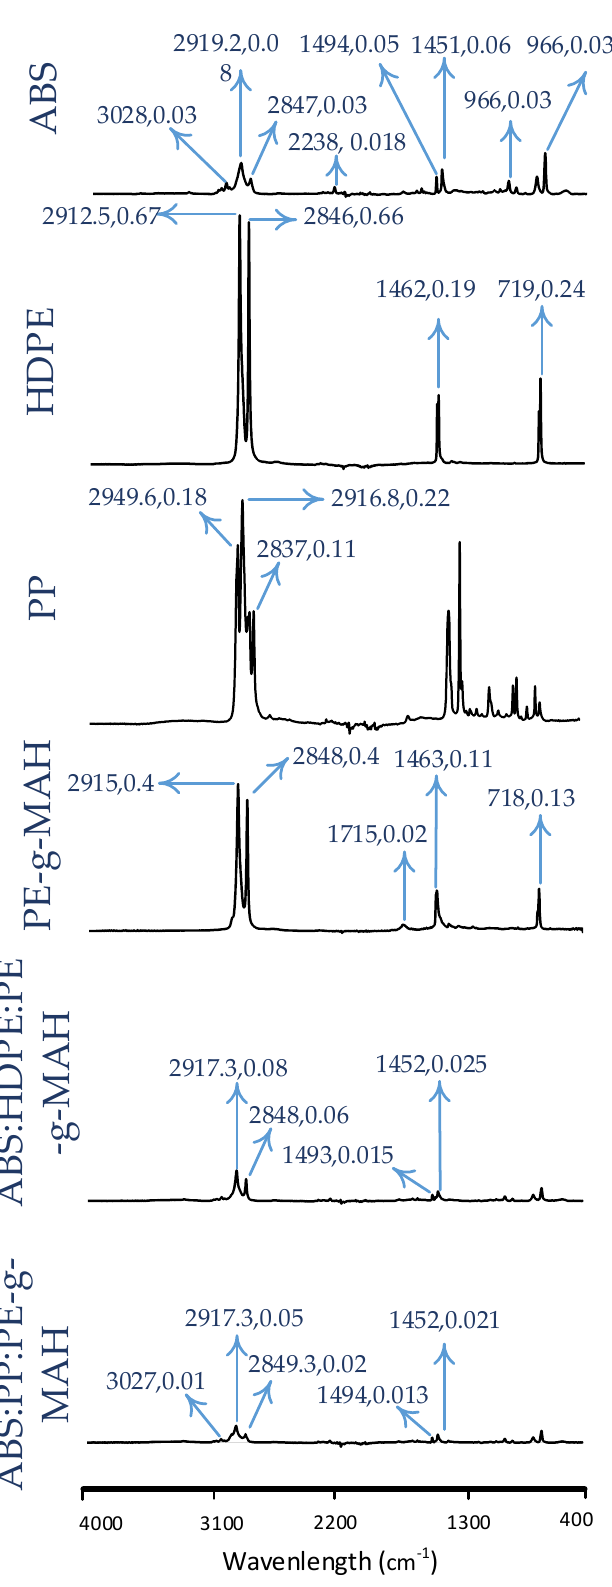
Figure 6. FTIR analysis for different polymers and 3D-printed blends. The analysis of ABS blend with HDPE shows visible variations as shown in Figure 6. The overall spectrum of ABS:HDPE:PE-g-MAH is similar to neat ABS. However, the differences are in form of shifts in wavelengths and decrease or increase of intensities.